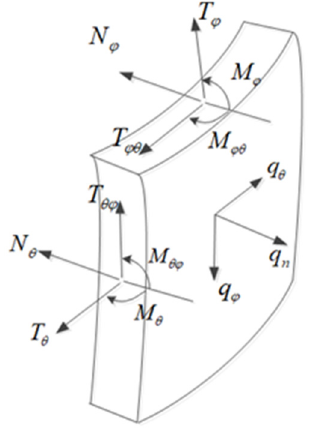
Figure 8. Section diagram of force.